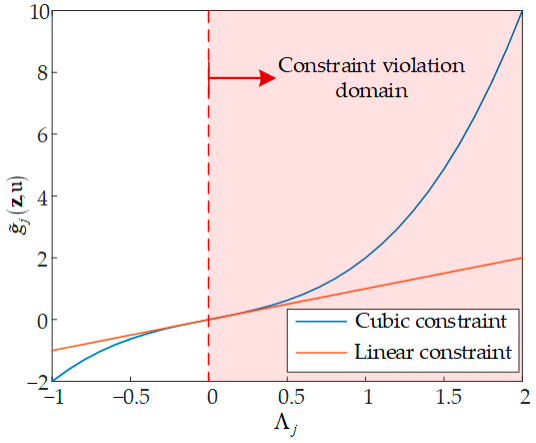
Figure 3. Comparison between traditional linear and cubic